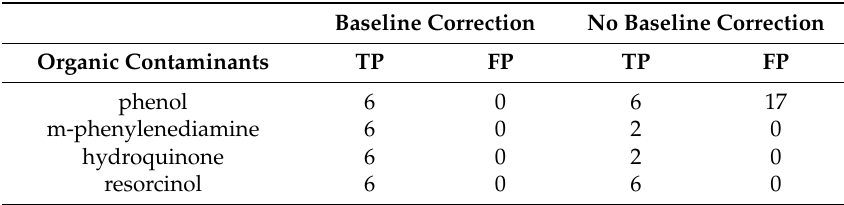
Table 5. Comparison the two methods based on the events’ level (Each organic contaminant includes 6 events). TP indicates the number of abnormal events detected; FP indicates the number of false positive events.